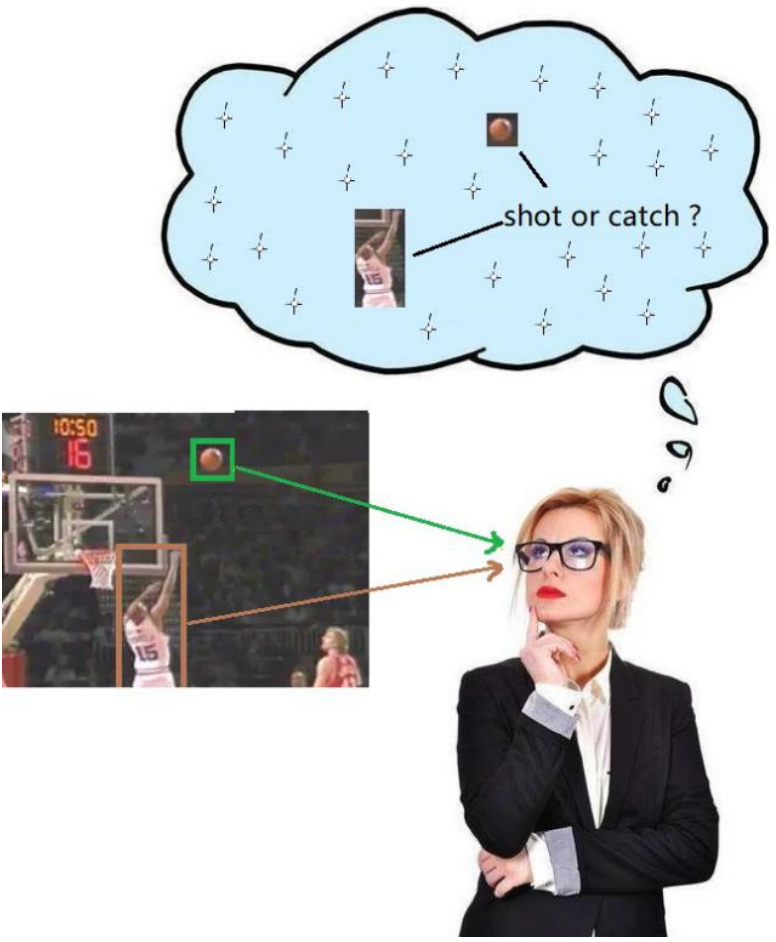
Figure 1. Person sees the scene and infers the relationship between the player and basketball.